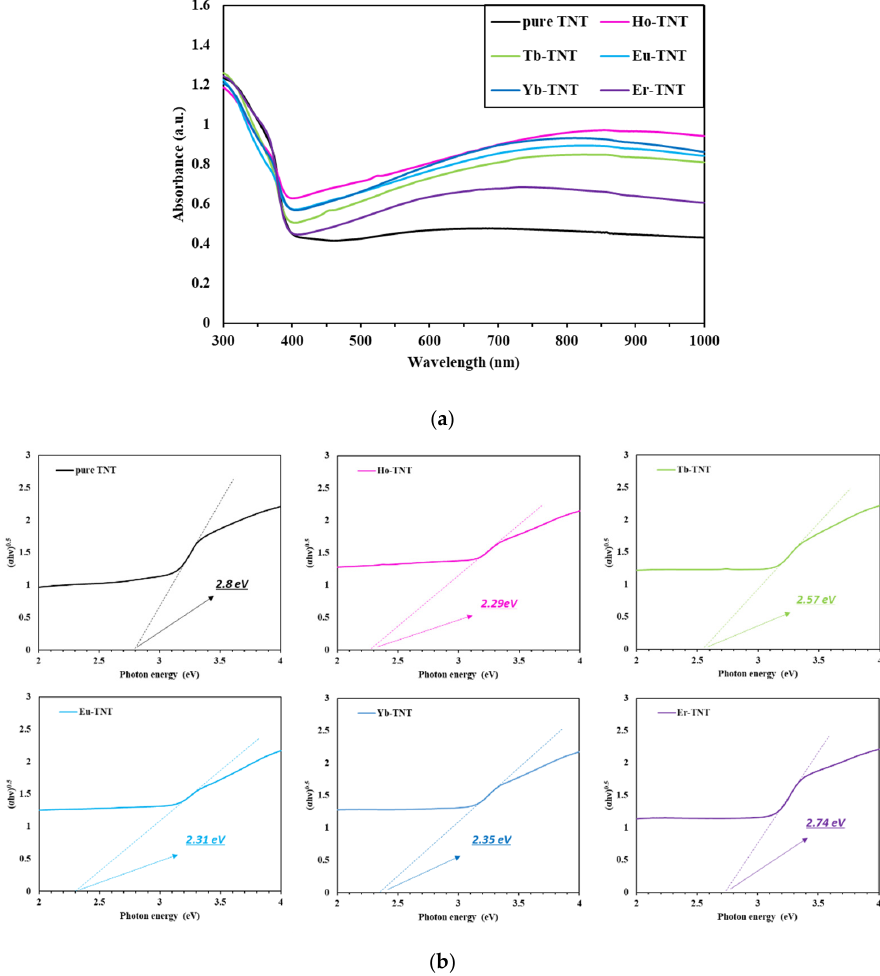
Figure 5. ( a ) UV–Vis ‐ diffused absorbance spectra; ( b ) Tauc plots.